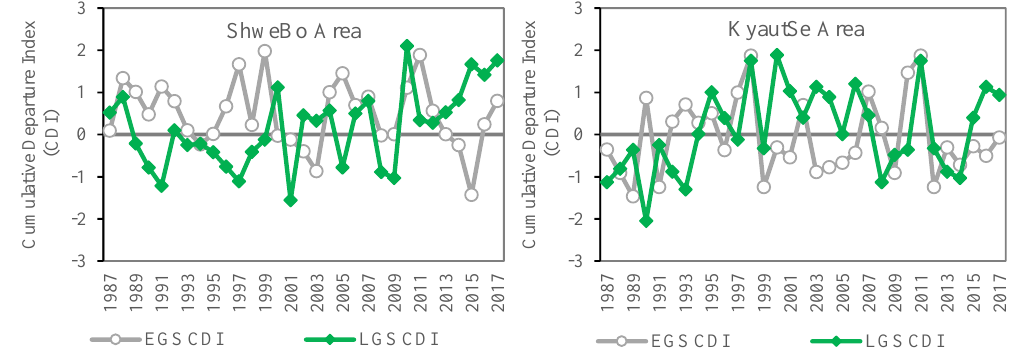
Figure 4. Growing season fluctuation of rainfall based on cumulative departure index between 1987 and 2017 (EGS: early growing season, LGS: late growing season).